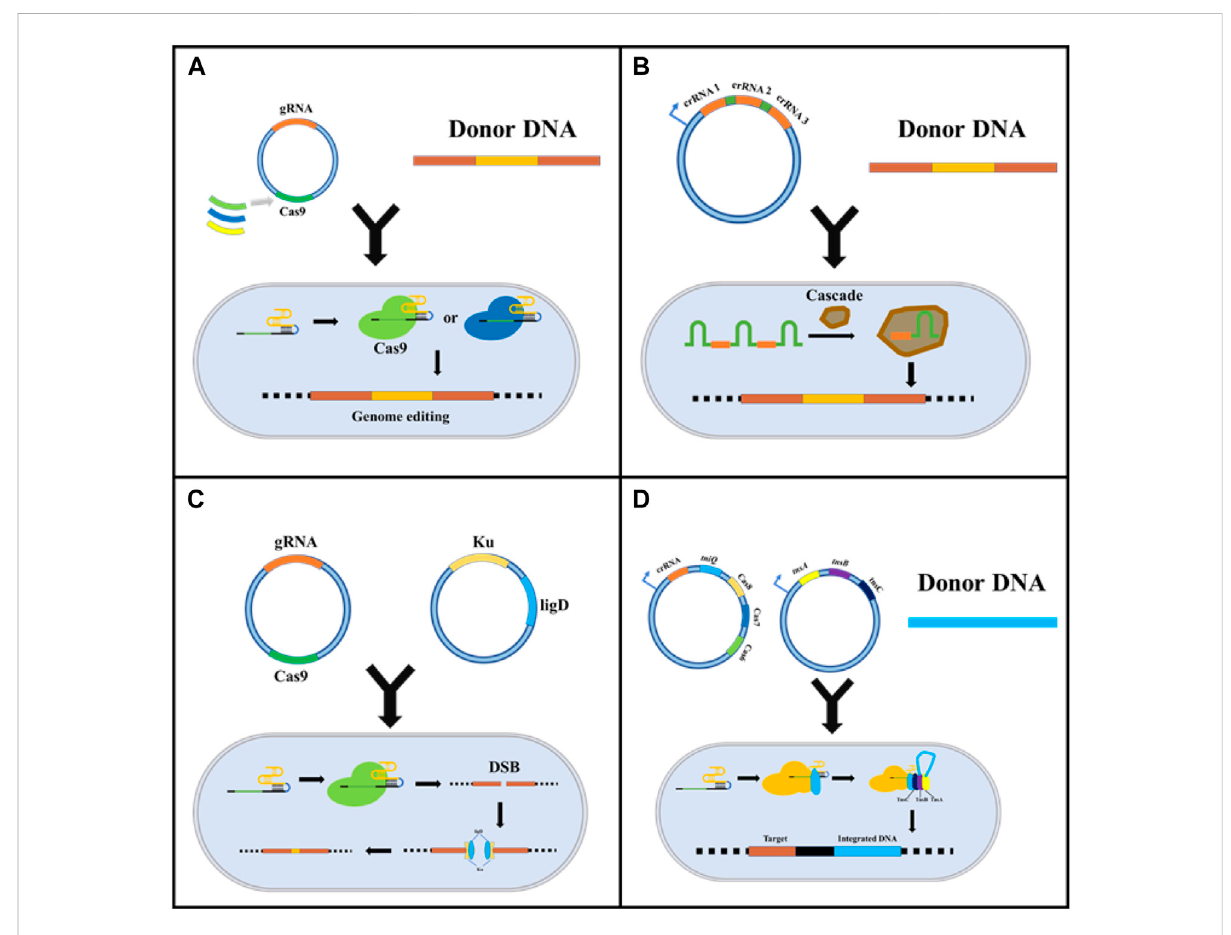
FIGURE 2 Strategies for reducing CRISPR/Cas9 system cytotoxicity. (A) Replacing Cas9 with other less toxic Cas proteins, such as dCas9 and CpfI; (B) UsingtheintracellularendogenousCRISPR/CasimmunesystemtoexpresscrRNAandrealizedtargetsites-editing; (C)